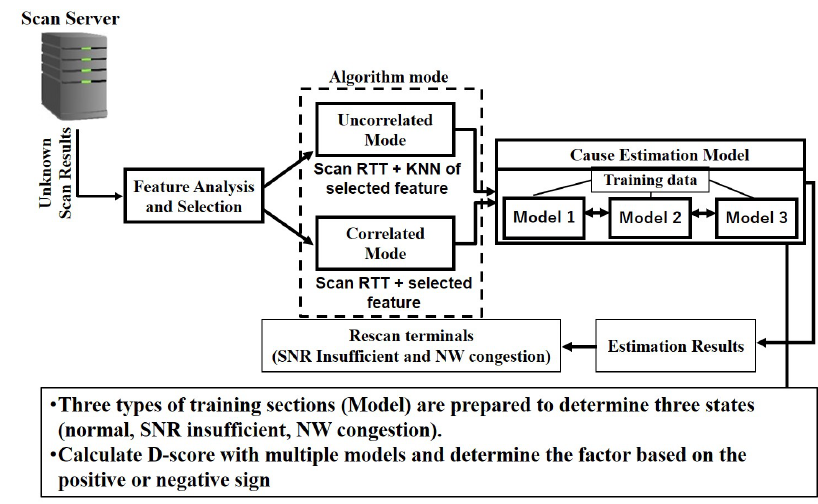
Figure 2. Scan failure/delay cause estimation process.